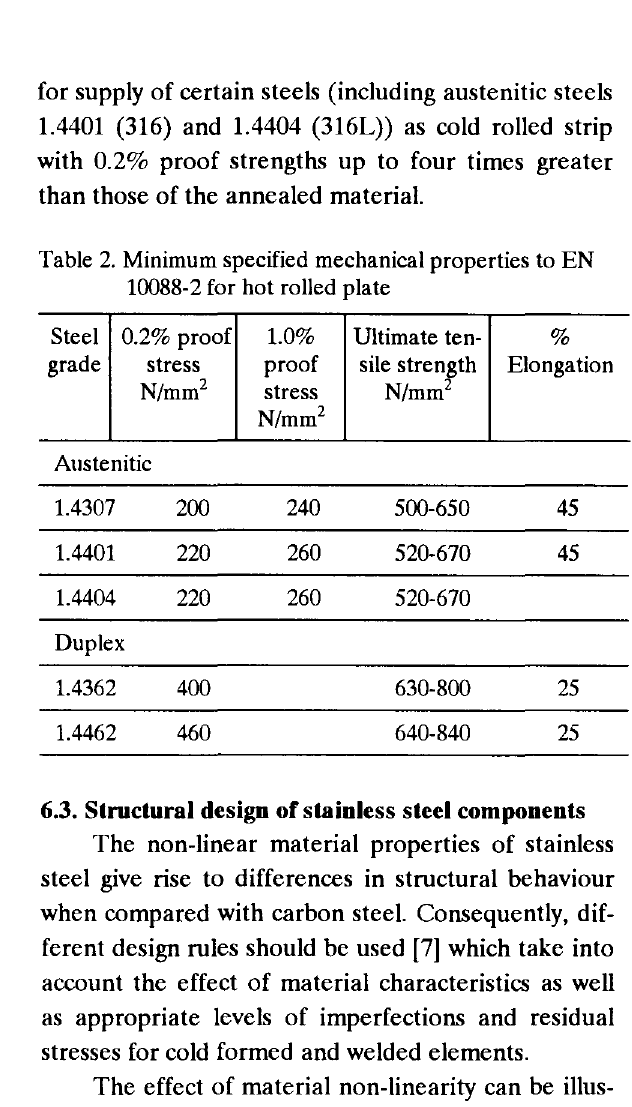
Table 2. Minimum specified mechanical properties to EN